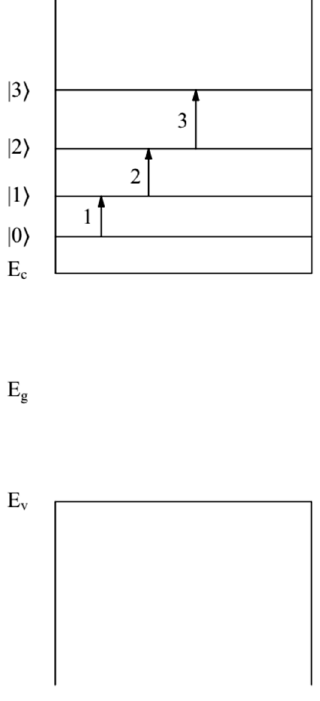
Figure 2. Band diagram of the QD { en } FAPbBr 3 . Quantum-confined energy levels Figure 2. Band diagram of the QD {en}FAPbBr (cid:2871) . Quantum-confined energy levels |0 〉= 𝐸 (cid:2869),(cid:2868),(cid:2868) = |0 (cid:105) = E 1,0,0 = 58 meV, |1 (cid:105) = E 1,1,1 = 122 meV, |2 (cid:105) = E 1,2,0 = 204 meV, |3 (cid:105) = E 1,3,1 = 316 meV. 58 meV, |1 〉= 𝐸 (cid:2869),(cid:2869),(cid:2869) = 122 meV, |2 〉= 𝐸 (cid:2869),(cid:2870),(cid:2868) = 204 meV, |3 〉= 𝐸 (cid:2869),(cid:2871),(cid:2869) = 316 meV. Electrons are in the Electrons are in the conduction band of QD { en } FAPbBr 3 . Arrows show electron transi- conduction band of QD {en}FAPbBr (cid:2871) . Arrows show electron transitions: electron transition (1) be- tions: electron transition (1) between levels |0 (cid:105) and |1 (cid:105) (the energy of such a transition is tween levels |0 〉 and |1 〉 (the energy of such a transition is ∆𝐸 (cid:2869),(cid:2868),(cid:2868)(cid:2869),(cid:2869),(cid:2869) (𝑎) = 64 meV), electron transition ∆ E 1,1,1 ( a ) = 64 meV), electron transition (2) between levels |1 (cid:105) and |2 (cid:105) (the energy of such a tran- 1,0,0 (2) between levels |1 〉 and |2 〉 (the energy of such a transition is ∆𝐸 (cid:2869),(cid:2869),(cid:2869)(cid:2869),(cid:2870),(cid:2868) (𝑎) = 82 meV) , electron tran- ( a ) = 82 meV ) , electron transition (3) between levels |2 (cid:105) and |3 (cid:105) (the energy of sition is ∆ E 1,2,0 sition (3) between levels |2 〉 and |3 〉 (the energy of such a transition is ∆𝐸 (cid:2869),(cid:2870),(cid:2868)(cid:2869),(cid:2871),(cid:2869) (𝑎) = 112 meV). The 1,1,1 ( a ) = 112 meV). The energies E c , E v , and E g = 2.43 eV correspond to the such a transition is ∆ E 1,3,1 energies 𝐸 (cid:3030) , 𝐸 (cid:3049) , and 𝐸 (cid:3034) = 2.43 eV correspond to the positions of the bottom of the conduction 1,2,0 positions of the bottom of the conduction band, the top of the valence band, and the bandgap QD band, the top of the valence band, and the bandgap QD {en}FAPbBr (cid:2871) , respectively. { en } FAPbBr 3 ,